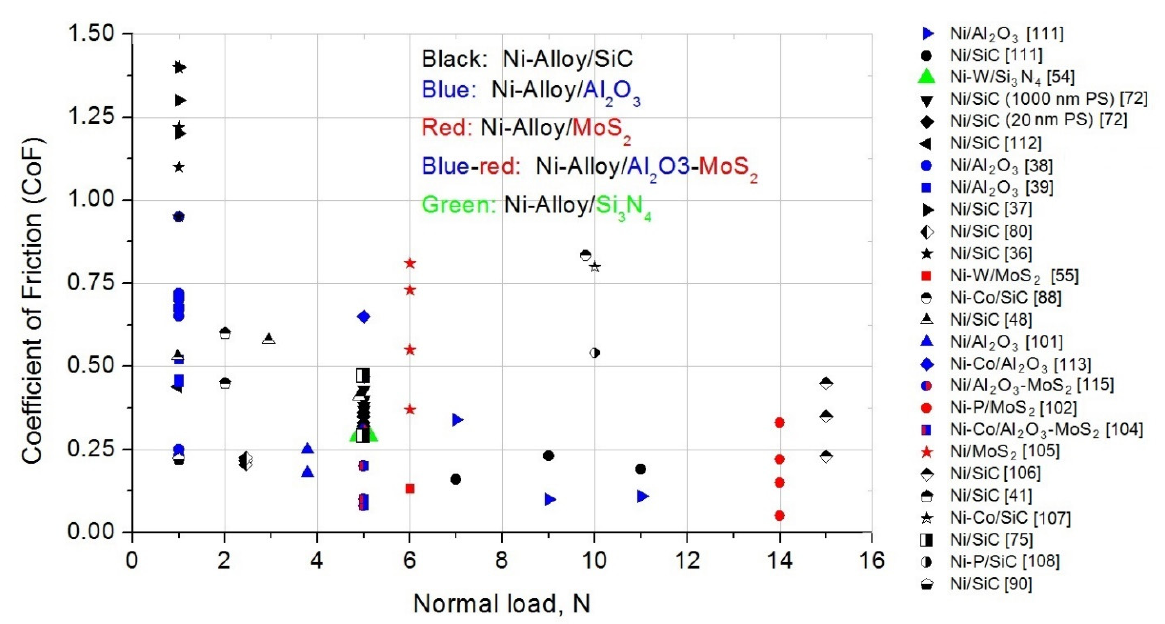
Figure 4. The effect of normal load on CoF in Ni-alloy MMCs. The CoF graph includes only dry friction measurements at room temperature for MMCs without annealing.